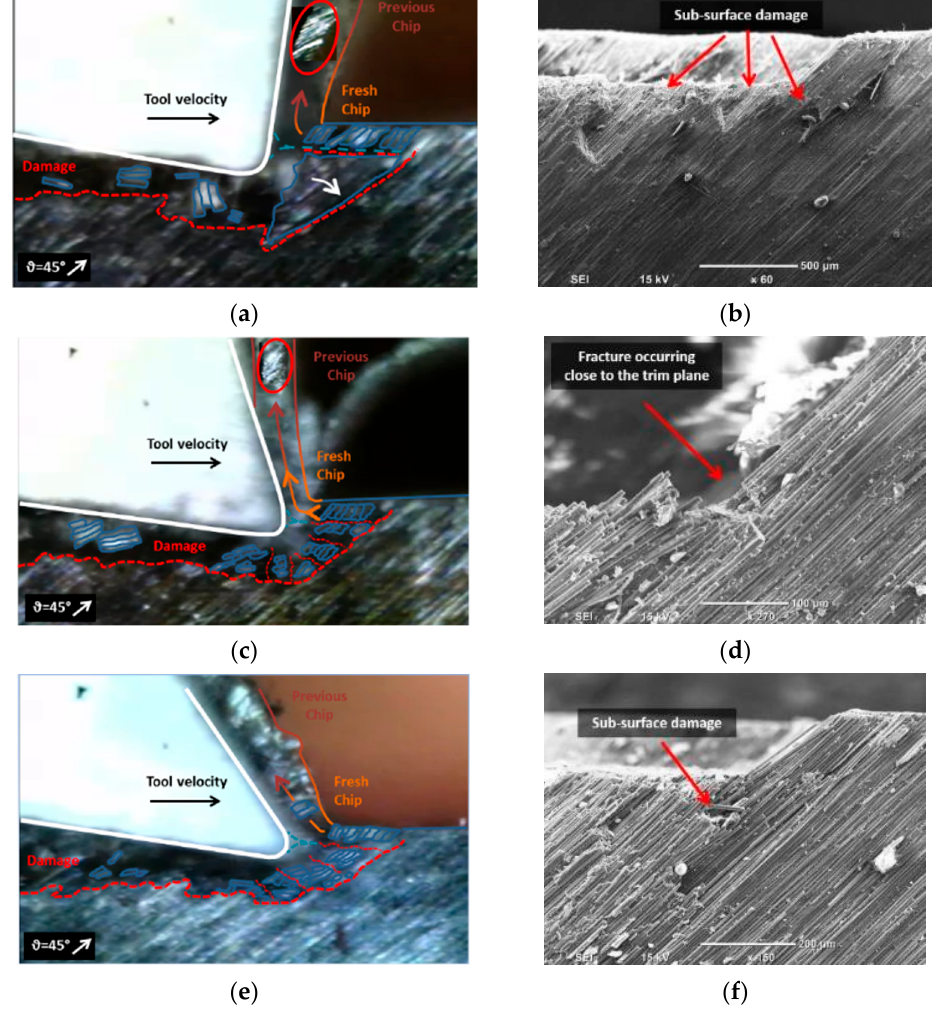
Figure 10. Chip formation at fibre orientation 45° and tool rake angle ( a , b ) − 10°; ( c , d ) 10°; ( e , f ) 30°.